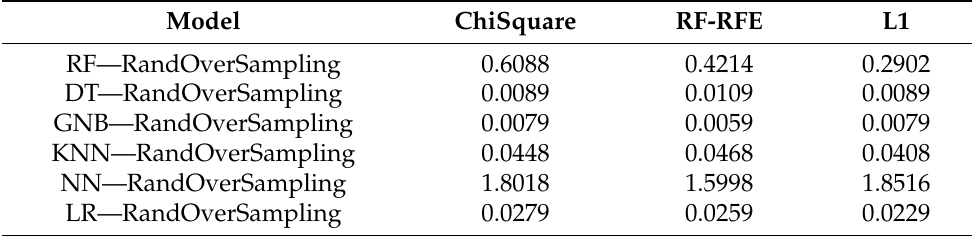
Table 9. Running time of the algorithms (in